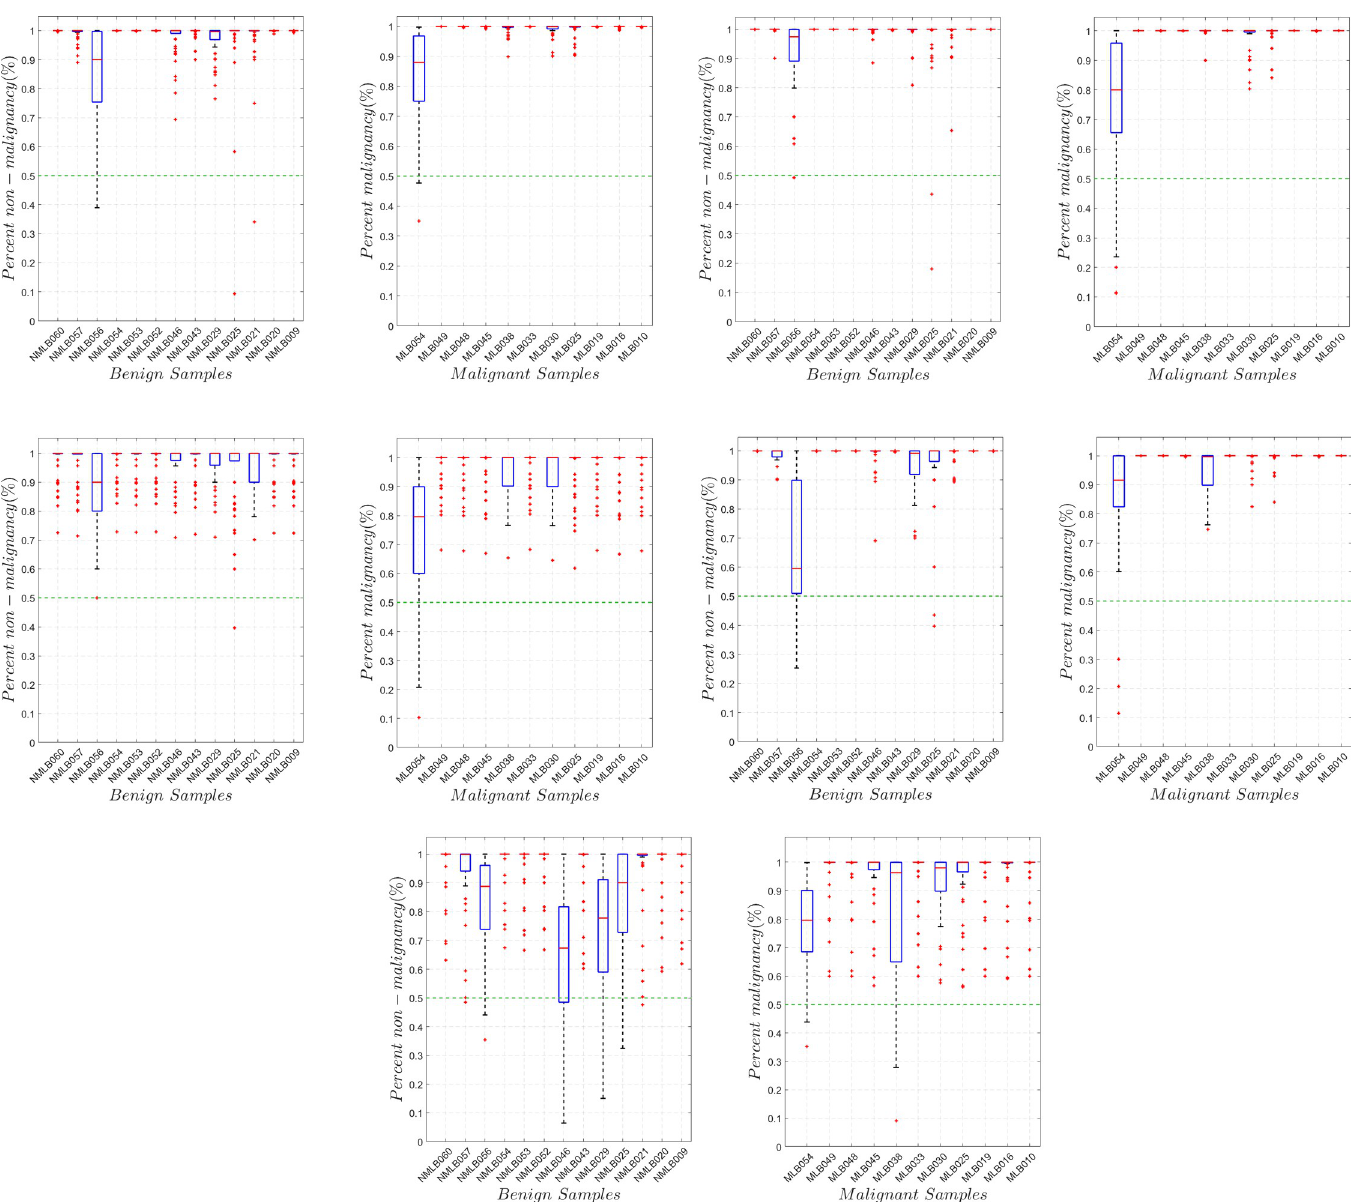
Fig 9. Prediction probability of NN models per discordant samples. The figures show the prediction probability of each NN model for the discordant benign (n = 13) and discordant malignant (n = 11) samples. The discordant samples were grouped according to the diagnosis by the pathologist of their respective study sites. All NN models show a median prediction score that is above the 0.5 (50%) mark, meaning that all the models had the same prediction as that of the diagnosis of the pathologist. A. Prediction probability of FNN2 models per discordant samples. B. Prediction probability of FNN4 models per discordant samples. C. Prediction probability of FNN8 models per discordant samples. D. Prediction probability of CNN models per discordant samples. E. Prediction probability of RNN models per discordant